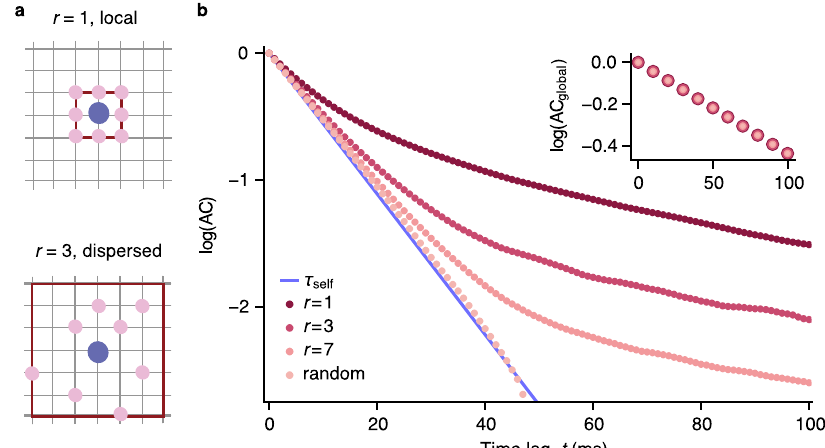
Fig. 6 | Dependence of local but not global timescales on the spatial network structure. a Schematic of local ( r =1) and dispersed ( r >1) spatial connectivity in the network model. Each unit (blue) is connected to 8 other units (pink) selected randomly within the connectivity radius r (brown line). b Shapes of the auto- correlations of individual units (AC) re fl ect the underlying local